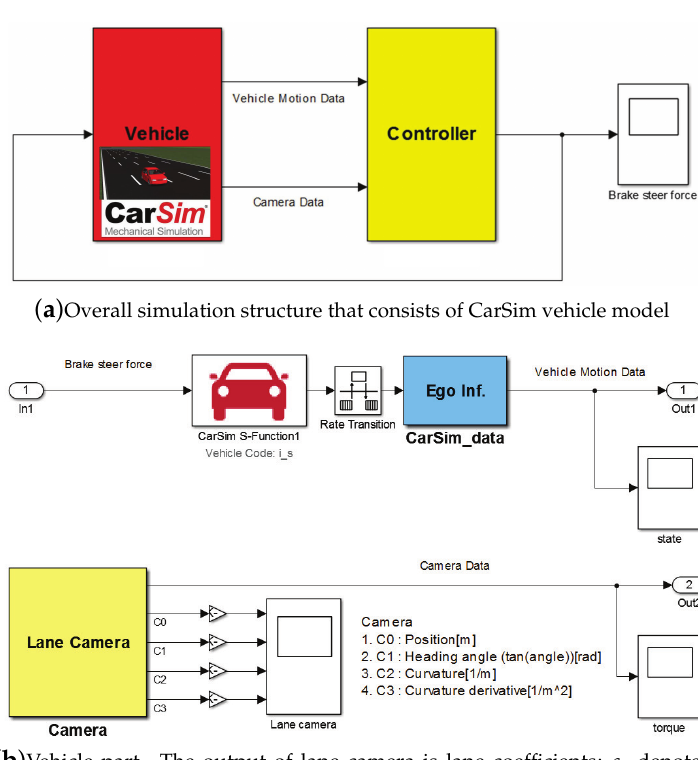
Figure 6. Vehicle and camera models used in the simulations